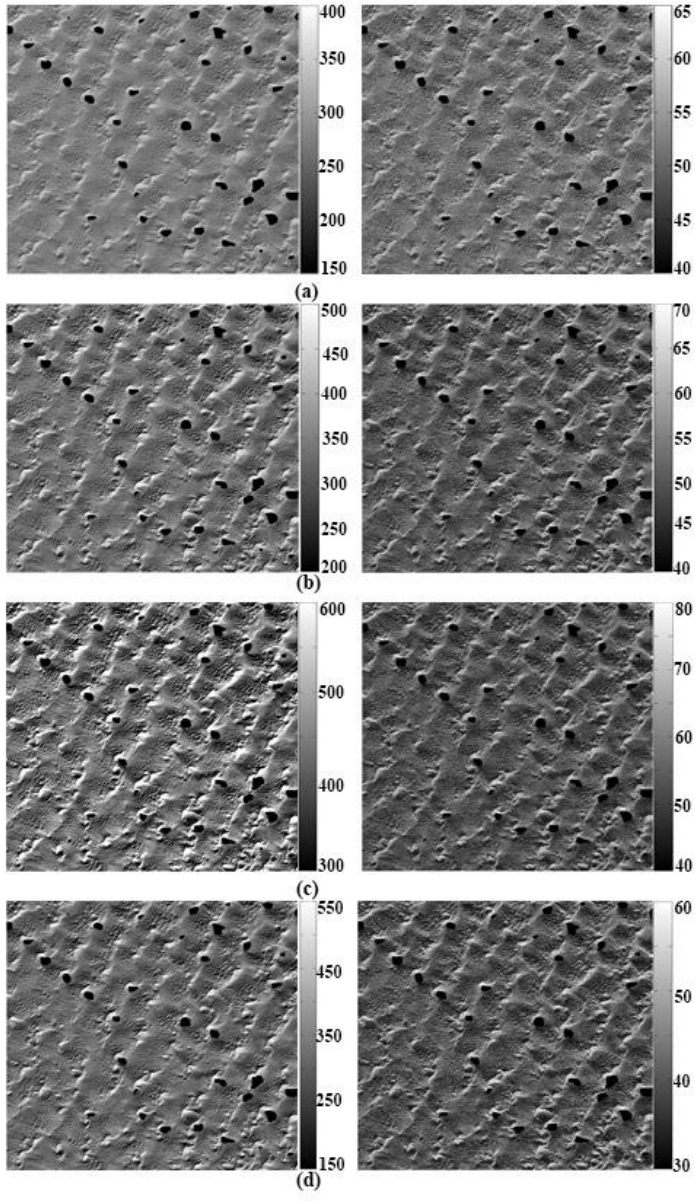
Figure 9. Example of the simulated TOA radiance and its corresponding DN of GF-1/WFV image on 11 February 2014. ( a ) Simulated TOA (right) and DN (left) of band 1. ( b ) Simulated TOA (right) and DN (left) of band 2. ( c ) Simulated TOA (right) and DN (left) of band 3. ( d ) Simulated TOA (right) and DN (left) of band